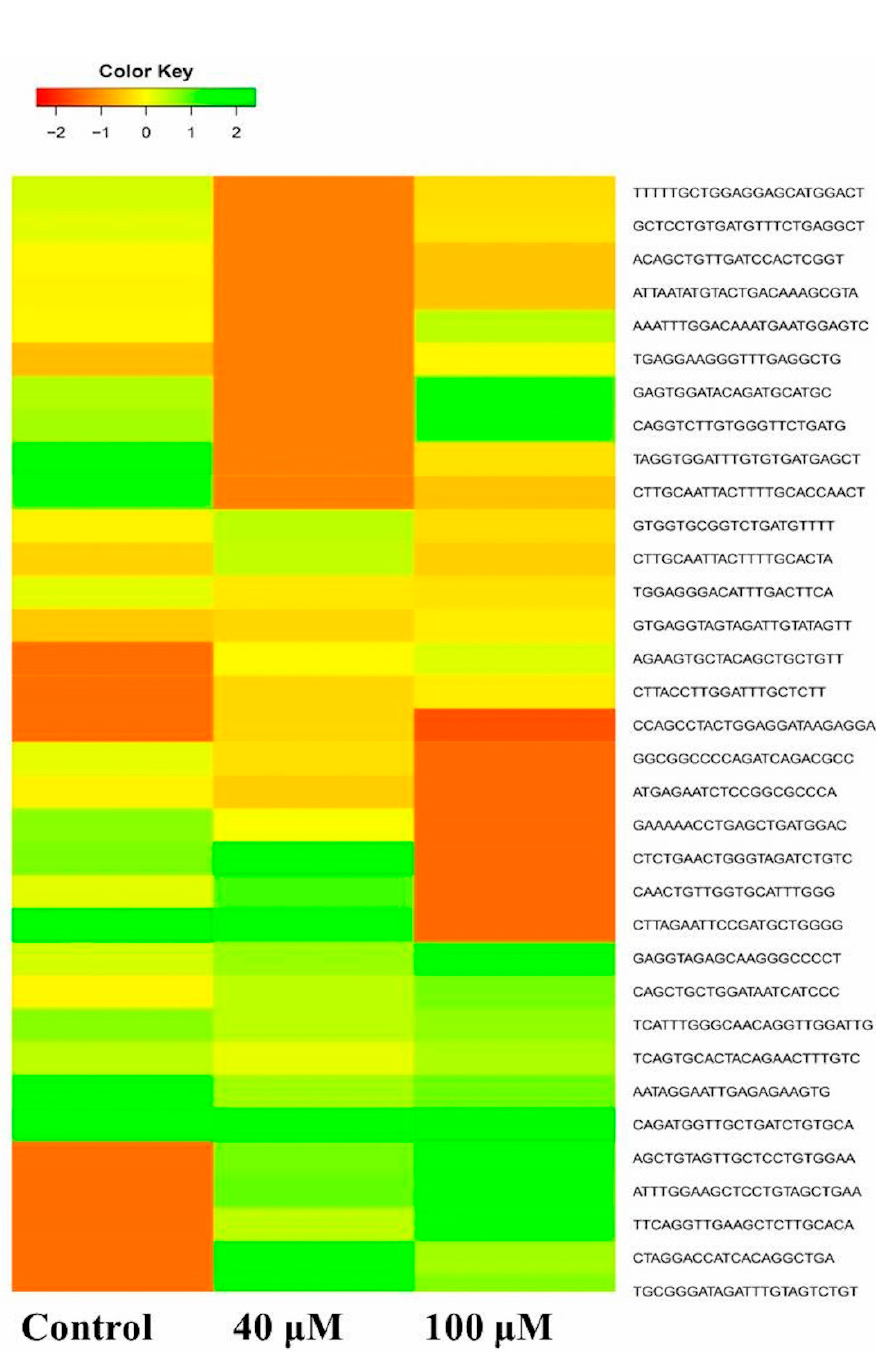
Figure 8. The expression profiles of putative novel microRNAs in the untreated control, 40, and 100 μ M EGCG treatments. Color key- red: up-regulation, green: down-regulation and yellow: neutral expression.